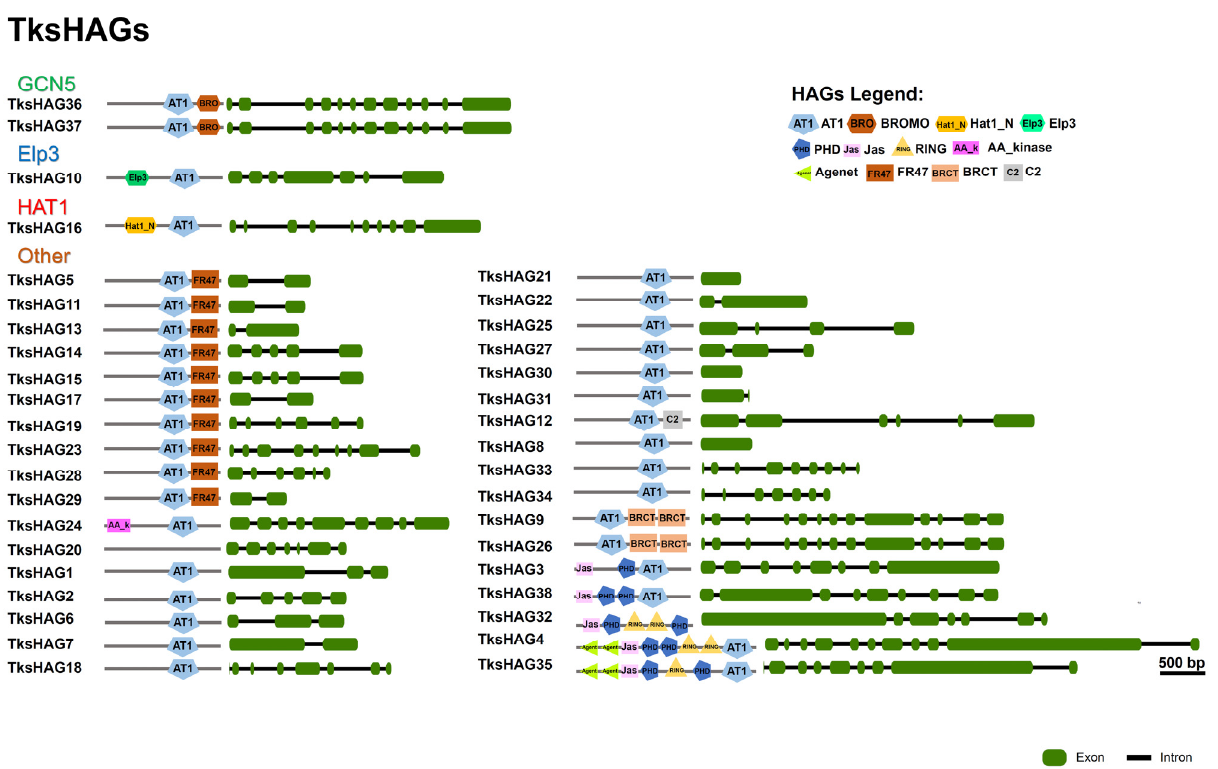
Figure 3. Phylogenetic tree of HAG ( A ) and HDA ( B ) proteins of Taraxacum kok-saghyz and Arabidop- sis thaliana (in colour according to their respective classes). The numbers near the tree branches rep- resent bootstrap values.